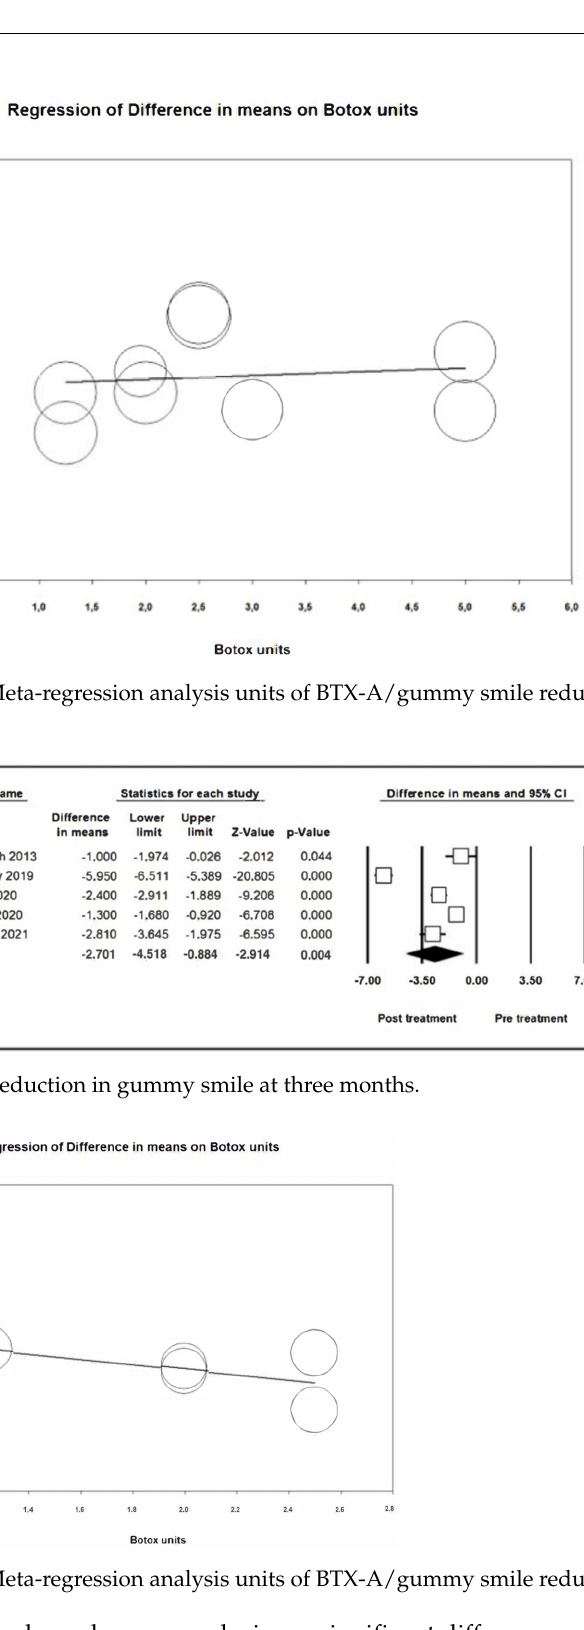
Figure 2. Reduction in gummy smile at two weeks.